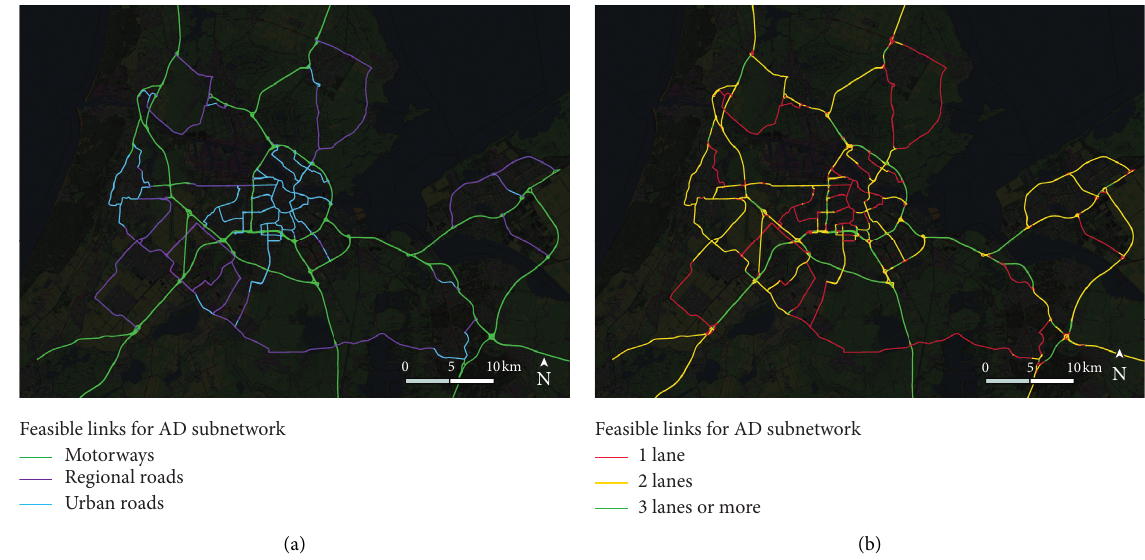
Figure 4: Road types and number of lanes for feasible AD subnetwork links in Amsterdam road network. (a) Road types. (b) Number of